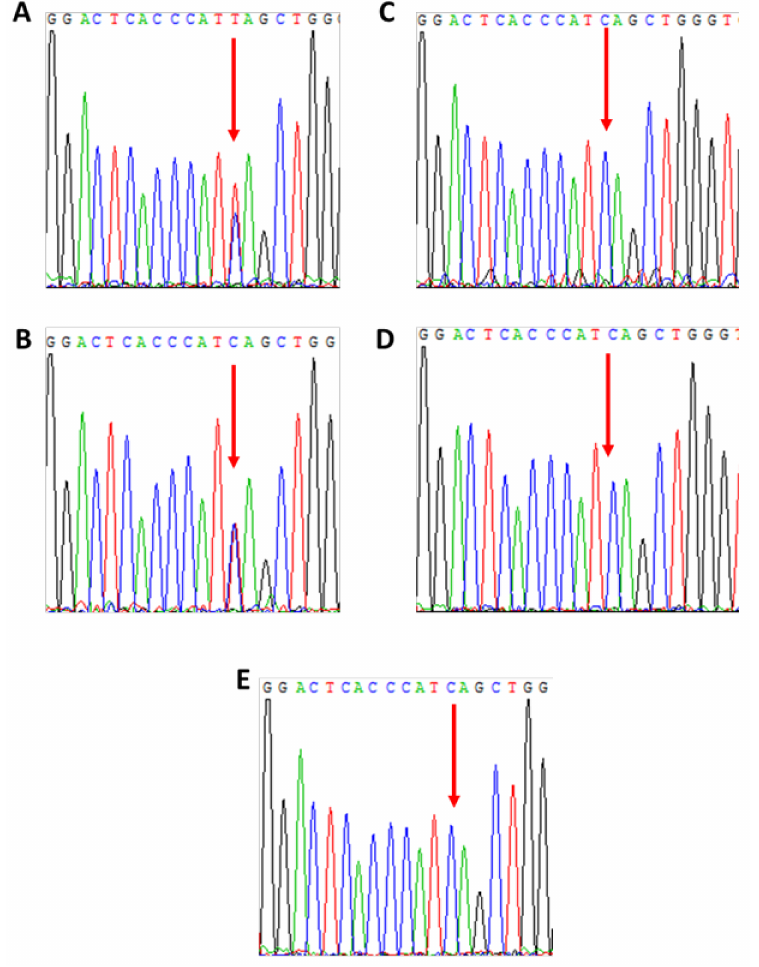
Figure 5. Analysis of family members of patient 3 for the NKAP mutation c.175C > T. ( A )—patient